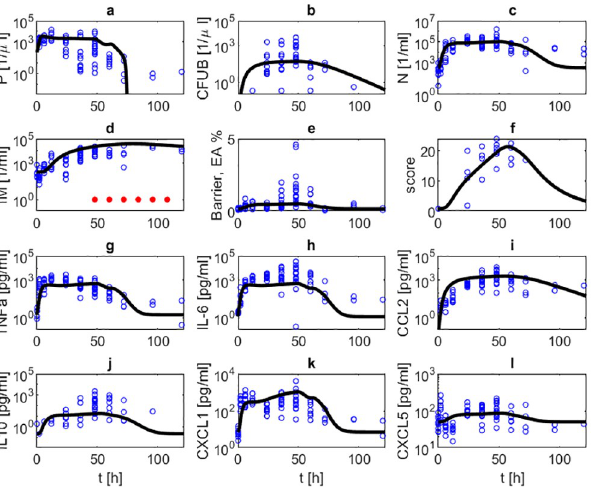
Fig 6. Infection with 5 � 10 6 Streptococcus pneumoniae treated with ampicillin (0.4 mg/mouse) every 12h, starting at 48h. We compare results of model simulation with data under antibiotic treatment. Time series of pneumococcal population in BAL (a) and blood (b), neutrophils in BAL (c), inflammatory macrophages in BAL (d), barrier function (e), histologic score (f), TNF- α in BALF (g), IL-6 in BALF (h), CCL2 in BALF (i), IL-10 in BALF (j), CXCL1 in BALF (k) and CXCL5 in BALF (l) are displayed. The solid black curve represents simulation results. Blue circles represent data. Red dots represent the time points of antibiotic treatment. Dynamics of state parameters are similar to that of antibiotic treatment starting at 24h but with some delay.